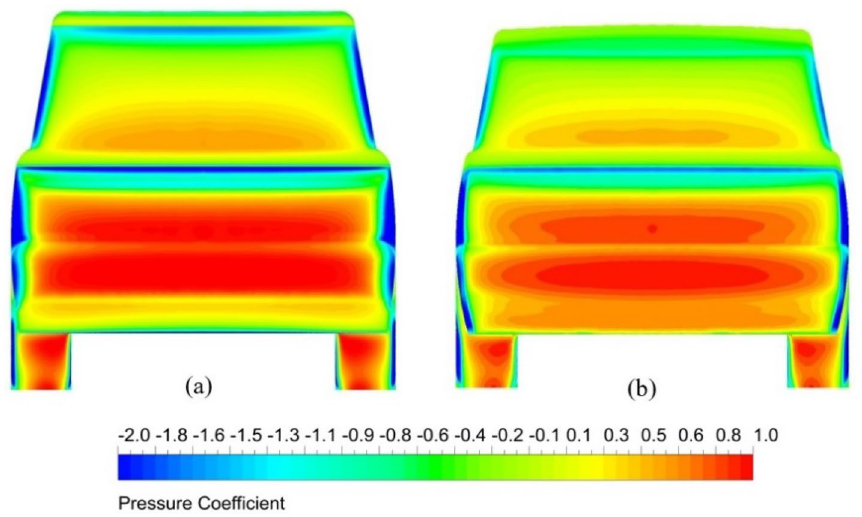
Figure 15. Front view of surface pressure distribution for two models of the LRD4: ( a ) the benchmark and ( b ) the modified model with diffuser and spare tire.